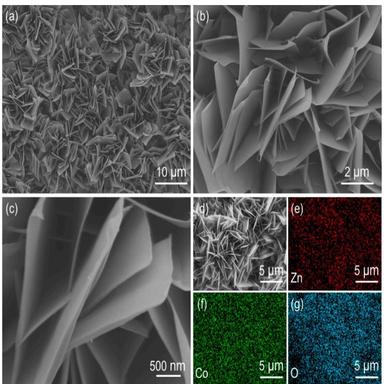
(a–d) SEM images of ZnCo2O4 NSs, and the corresponding elemental mappings of (e) Zn, (f) Co, and (g) O.